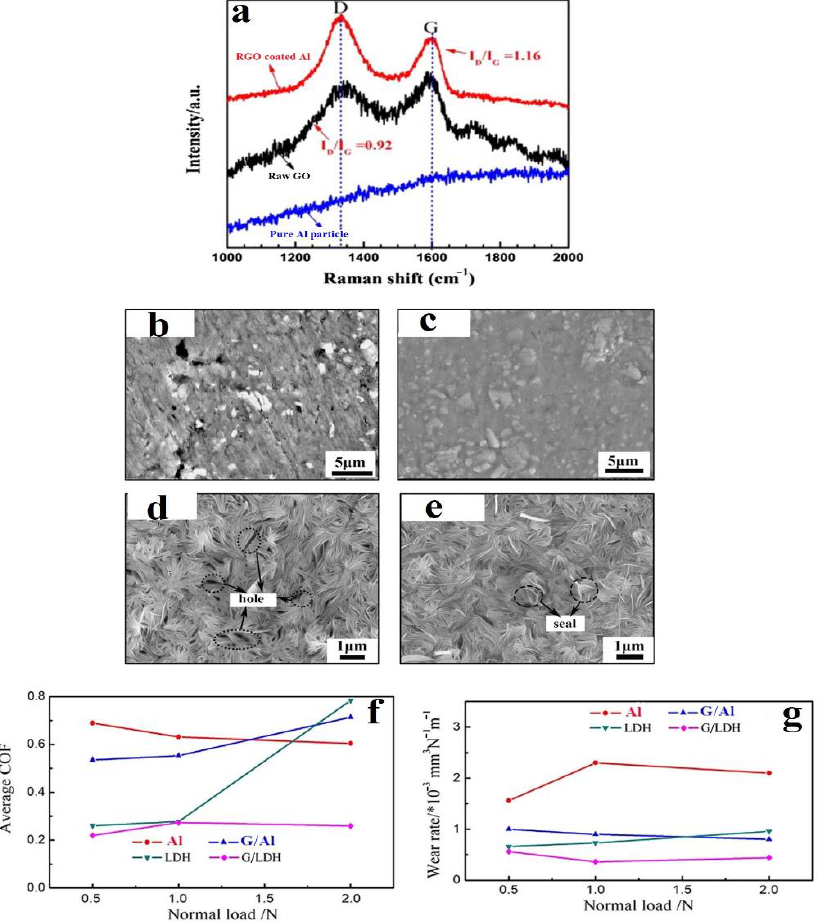
Figure 8. ( a ) Raman spectra of pure Al, GO, and RGO coated on Al pre-CS, ( b ) SEM image of pure Al CS coating, ( c ) SEM image of GNP/Al CS coating, ( d ) SEM image of LDH (Layered Double Hydroxide) CS coating, ( e ) SEM image of GNP/LDH CS coating, ( f ) COF (coefficient of friction), and ( g ) wear rate. Presented with permission from [70].